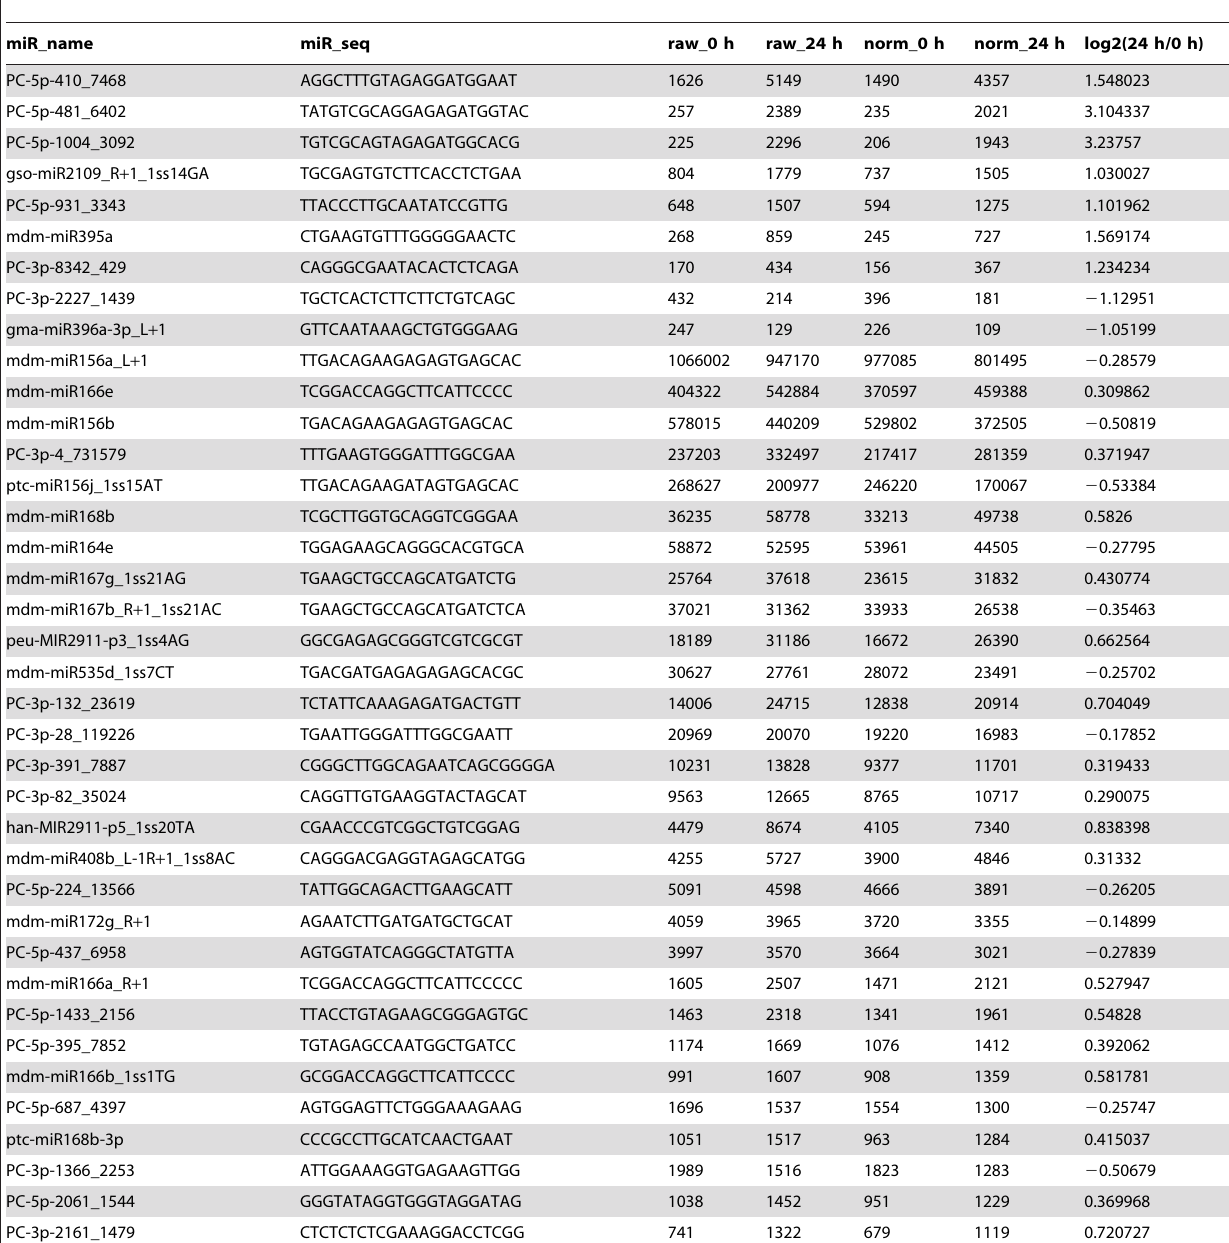
Table 2. Differentially-expressed miRNAs in strawberry fruit stored at 20 u C for 0 and 24 h. (More abundant were shown in Table